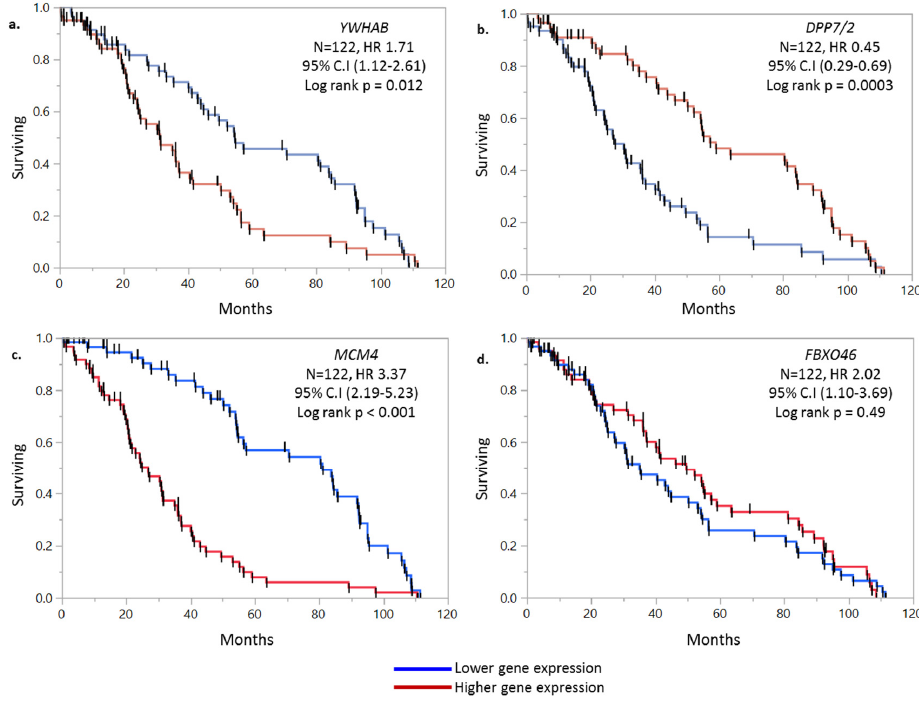
Figure 3. Kaplan-Meier curve of ( a ) YWHAB , ( b ) DPP7/2, ( c ) MCM4 , ( d ) FBXO46 from the external dataset. The median gene expression was used as a cut-off point for higher and lower gene expression groups.